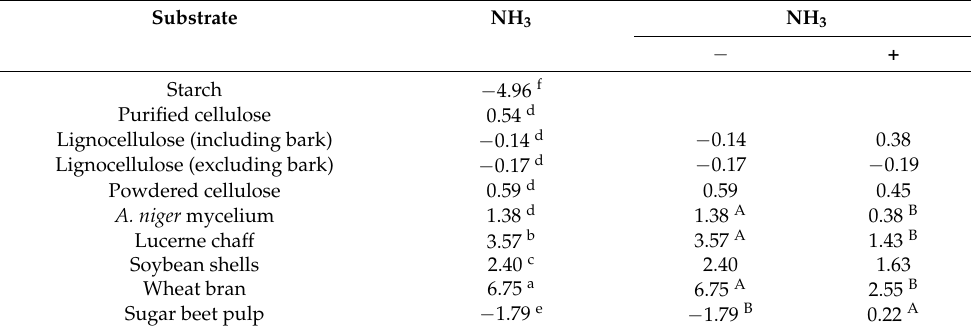
Table 7. Least squares means of NH 3 concentration (mmol/L) in fecal inoculum expressed as the difference between NH 3 concentration from fermentation of substrates and NH 3 concentration from background fermentation in blanks and the effect of enzymatic pre-digestion of the substrates.